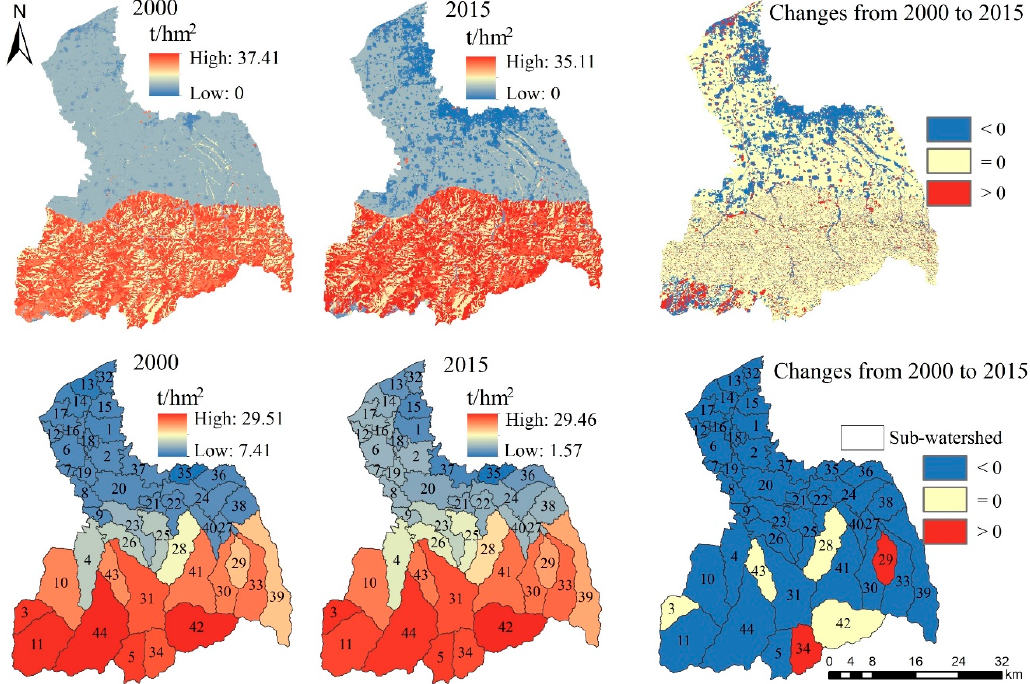
Figure 6. The spatial distribution and spatial–temporal changes of climate regulation (CR).